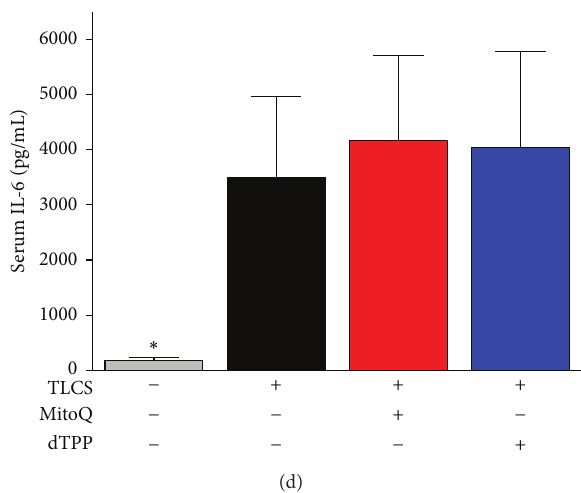
Figure 6: Effects of MitoQ on TLCS-AP. (a) Histopathology scores: (i) overall, (ii) oedema, (iii) inflammation, and (iv) necrosis. (b) Serum amylase. (c) Pancreatic MPO activity (normalized to CER-AP group). (d) Serum IL-6 levels. ∗ 𝑃 < 0.05 when compared with all other groups. Values are the mean ± SEM ( 𝑛 = 6 –8 mice per